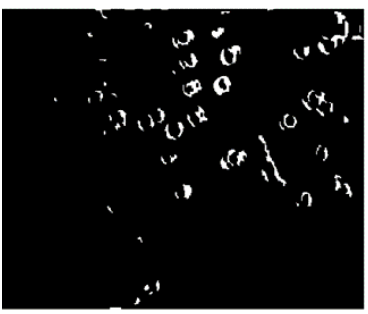
Figure 6. Depicting the outcome of Class2 PoC image when algorithm of PoC 1 Class was